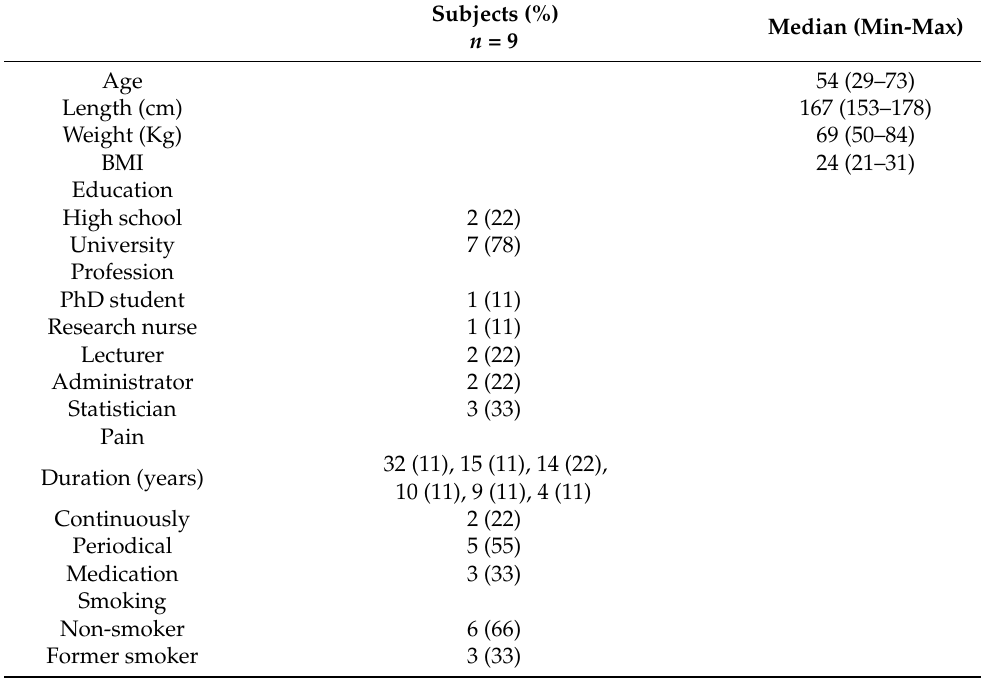
Table 1. Background